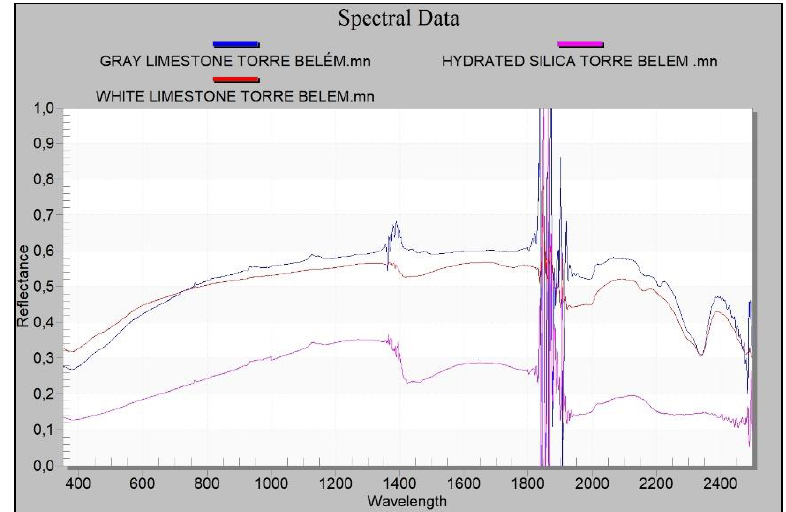
Figure 22. Reflectance spectral signatures of ashlars in the Tower of Belém.